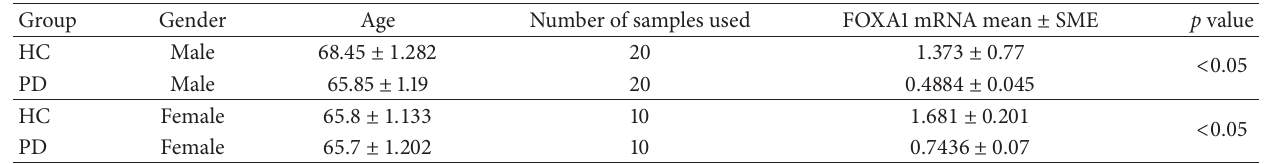
Table 4: FOXA 1 gene expression versus 𝛽 -actin as internal control in all